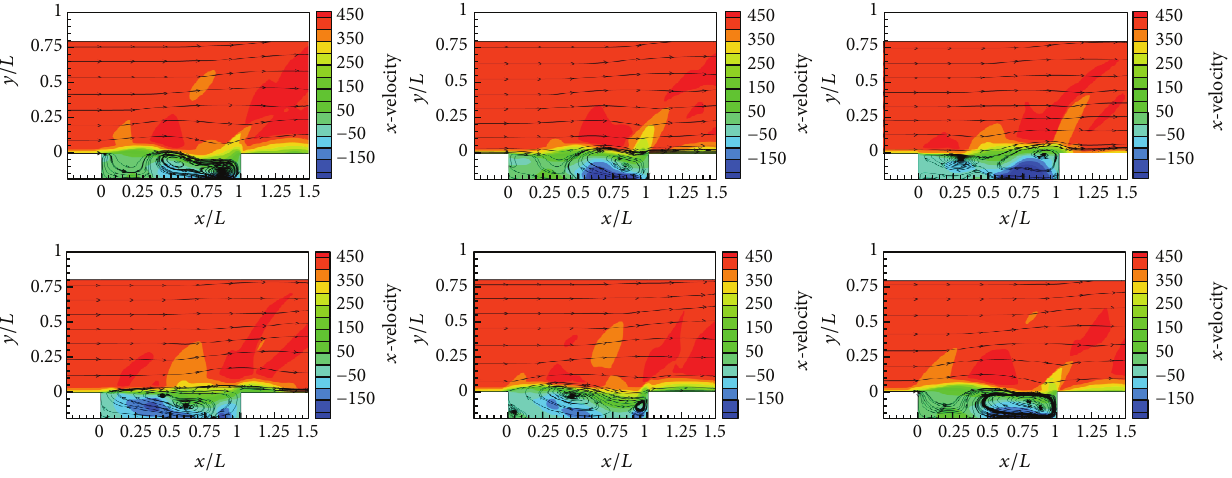
Figure 9: 𝑥 -velocity contours of cavity flow with L/D ratio of 5.07.